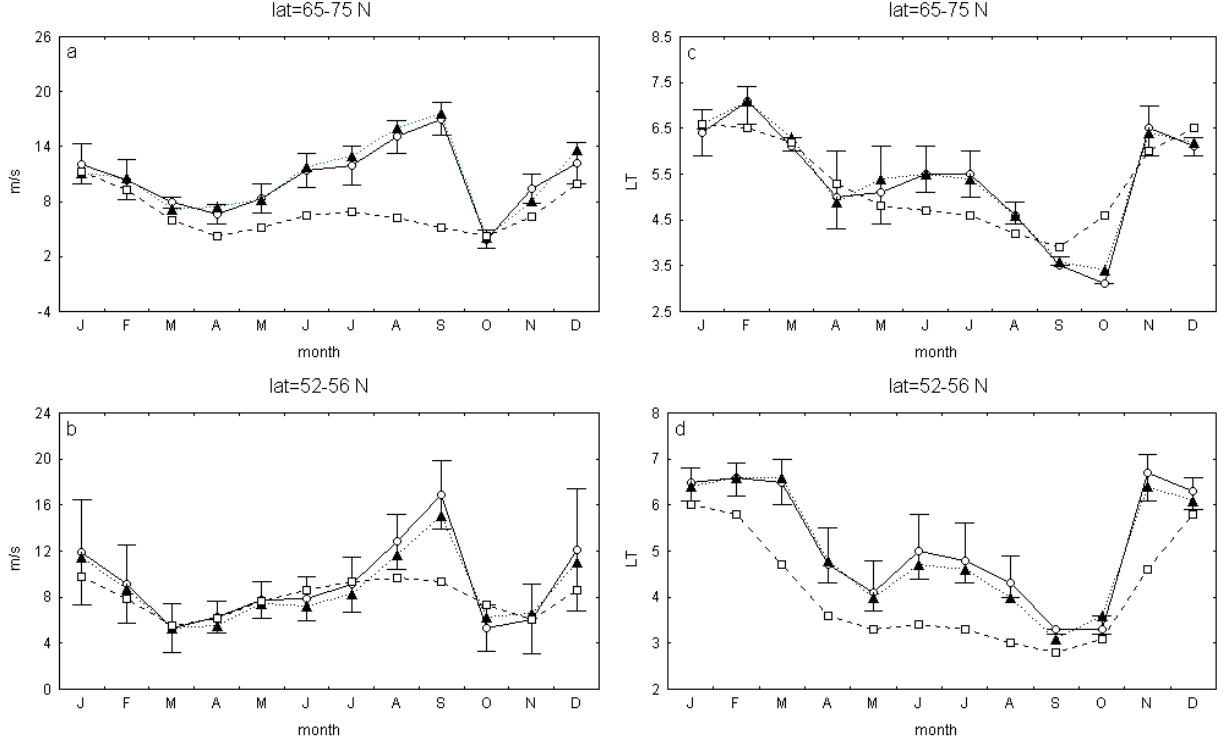
Fig. 9. The zonally averaged seasonal course of the semidiurnal tide at 90km; the error bars correspondend to the r.m.s. errors for vector averaged values: ( a , b ) − amplitude of meridional component, ( c , d ) − phase of maximum of meridional component. − o − experimental data, −− (cid:3) −− HWM-93, ... N